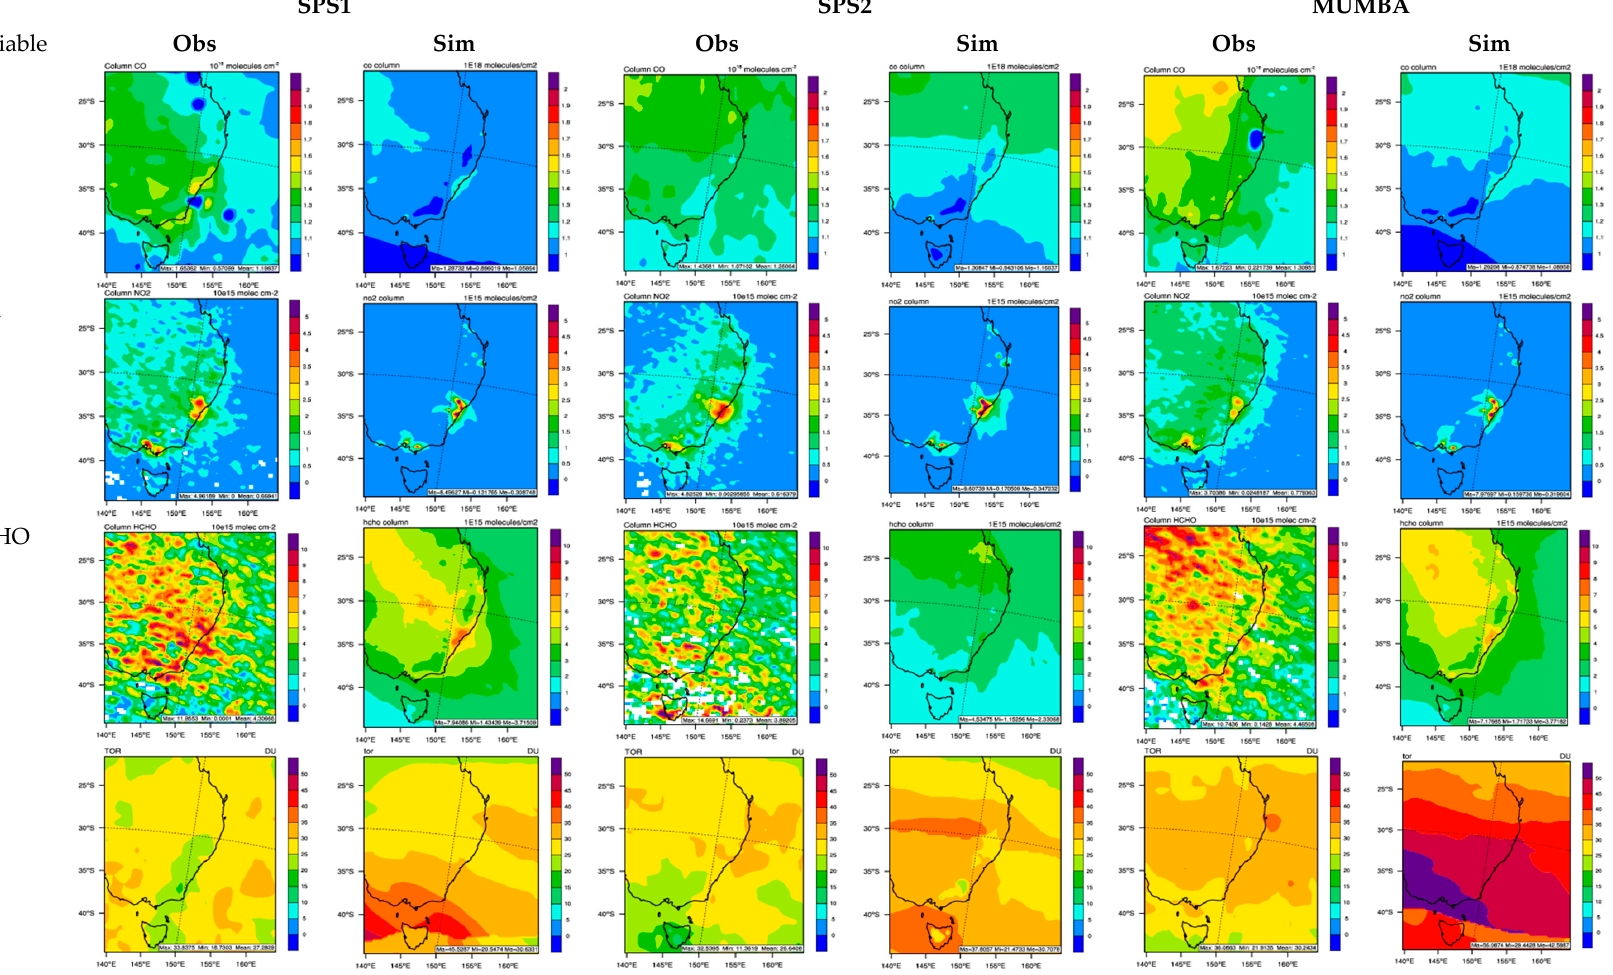
Figure 11. Observed and simulated column mass abundances over southeastern Australia (d02). The simulation results are from WRF/Chem-ROMS.